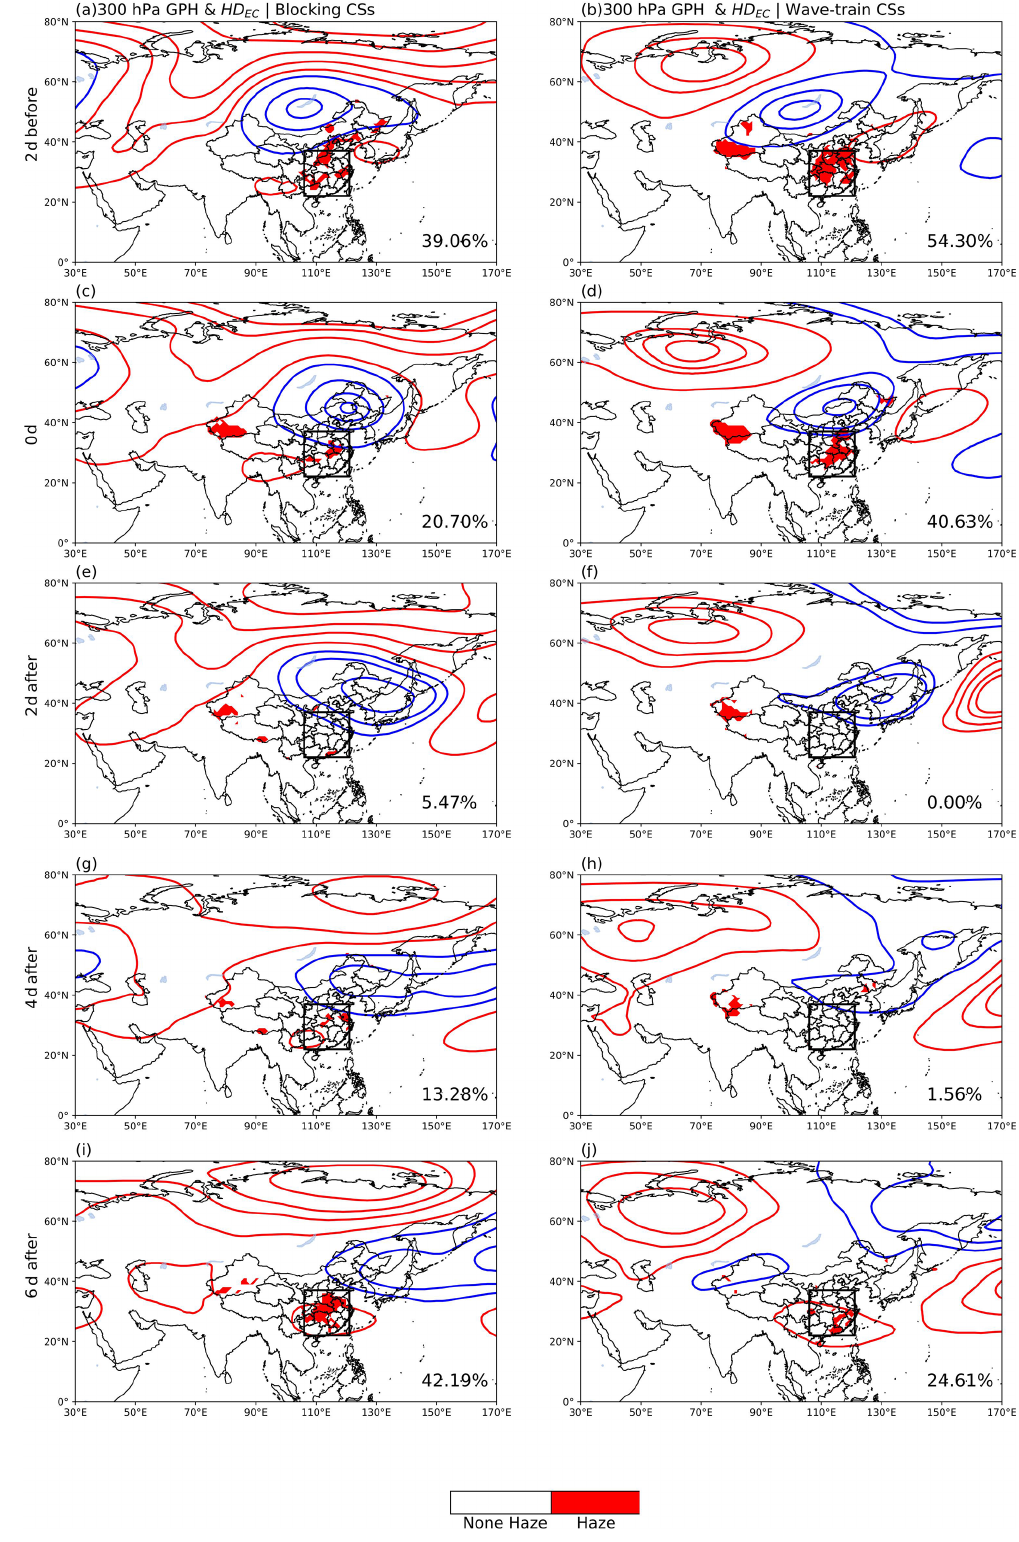
Figure 4. Composite of GPH anomalies at 300hPa (contour; in intervals of 20gpm) from − 2 to 6d relative to the outbreak of CSs and the corresponding spatial distribution of HD EC (shading; only the areas are shown which are statistically significant at the 95% confidence level by a t test) for blocking CSs (a, c, e, g, i) and wave-train CSs (b, d, f, h, j) . The number in the lower right corner of each figure represents the ratio of the grid of HD EC to that of